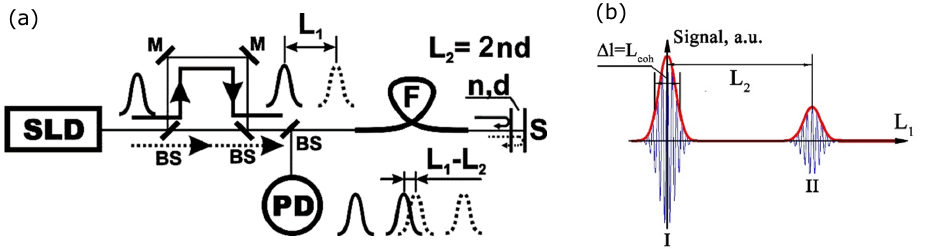
Figure 1. Tandem low-coherence interferometry: ( a ) TLCI scheme. ( b ) Form of a signal in the TLCI system: SLD—superluminescent diode, BS—beamsplitter, M—mirror, F—optical fiber, S—sensor, PD—photodetector; n,d—the refraction index and length of sensor, L 1,2 —optical delays in the reference interferometer and sensor,